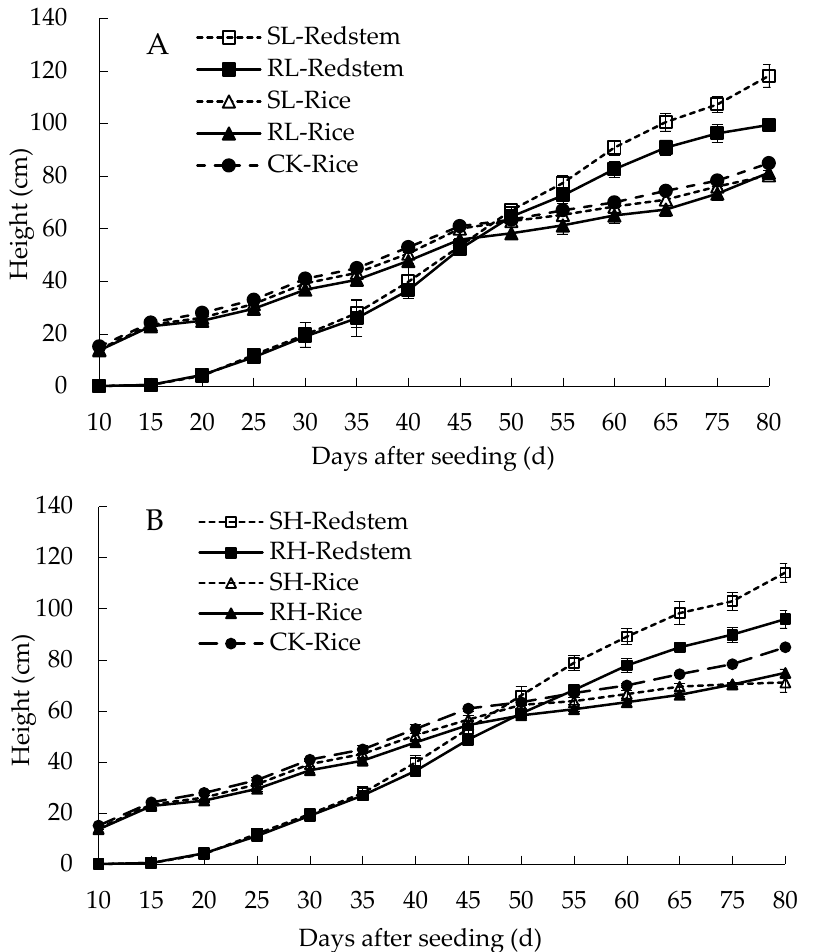
Figure 1. Height (mean ± standard error) of two eared redstem biotypes and paddy rice over time at ( A ) a low eared redstem density of 58 plants m − 2 or ( B ) a high eared redstem density of 288 plants m − 2 . The letters L and H refer to low and high densities, respectively. The letters S and R refer to BSM-susceptible and BSM-resistant biotypes, respectively. CK is the control in which only rice was planted. The rice seeding rate was 60 kg ha − 1 in all treatments.